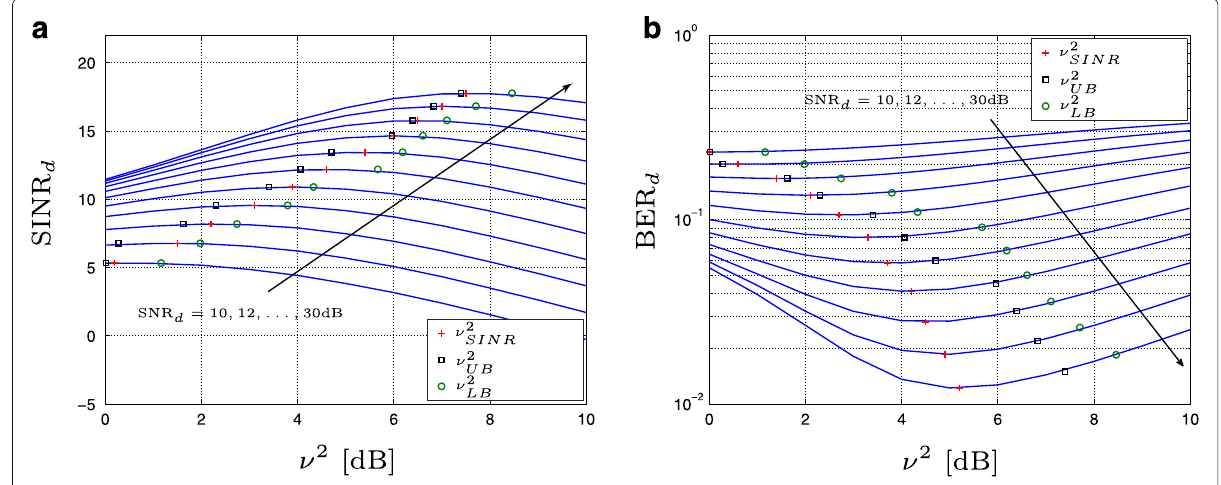
Fig. 5 Minimization of BER for the SSPA model with p = 2, A s = 1, and SNR d = 10,12, ... ,30 dB. Rayleigh relay-destination